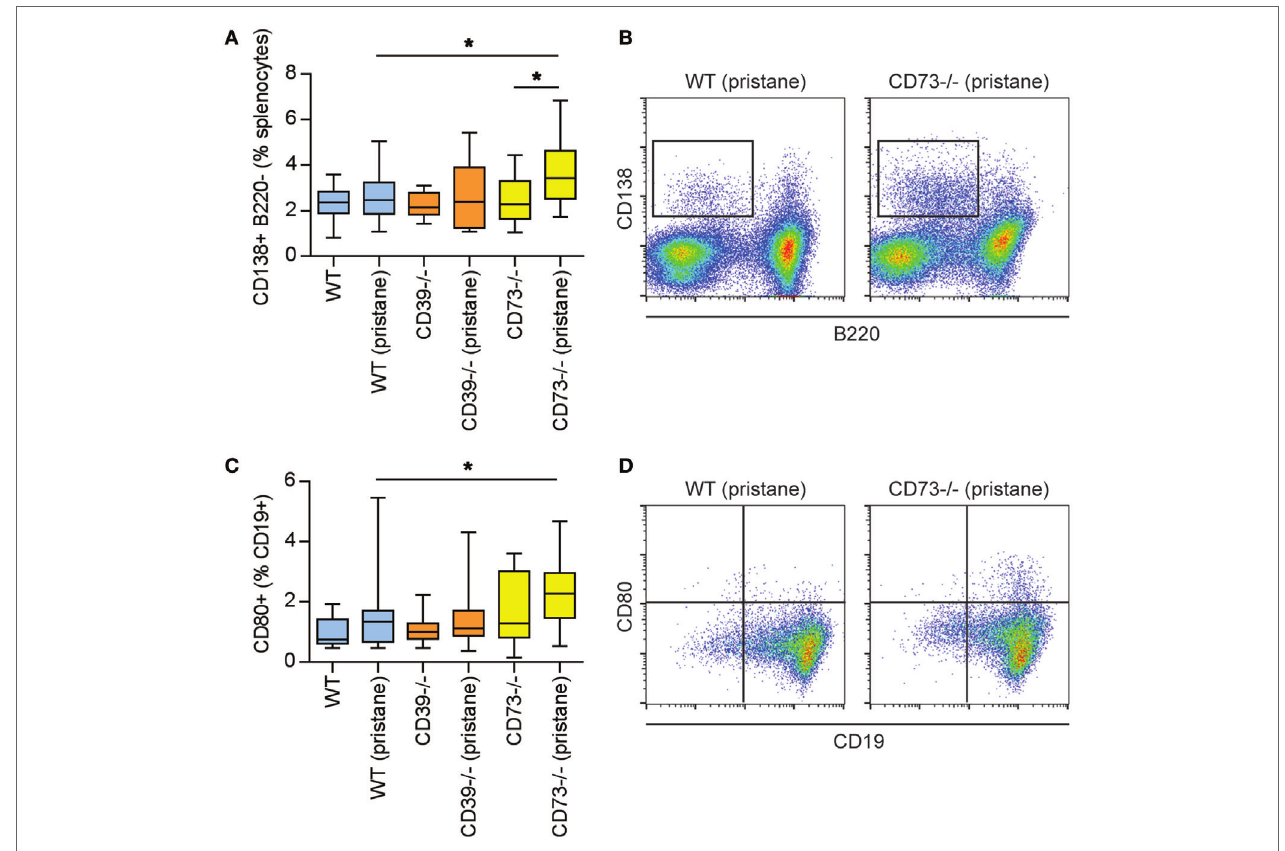
FigUre 3 | Modulation of plasma cells and B cells by ectonucleotidase deficiency in pristane-treated mice. Mice were administered either saline or pristane, as indicated. 36 weeks later, splenocytes were analyzed by flow cytometry. (a) CD138 + B220 − plasma cells, presented as the percentage of total splenocytes. (B) Representative data as presented in panel (a) . (c) CD80 + activated B cells, presented as the percentage of CD19 + B cells. (D) Representative data as presented in panel (c) . N = 10 per control group and 17–19 per pristane group; * p <